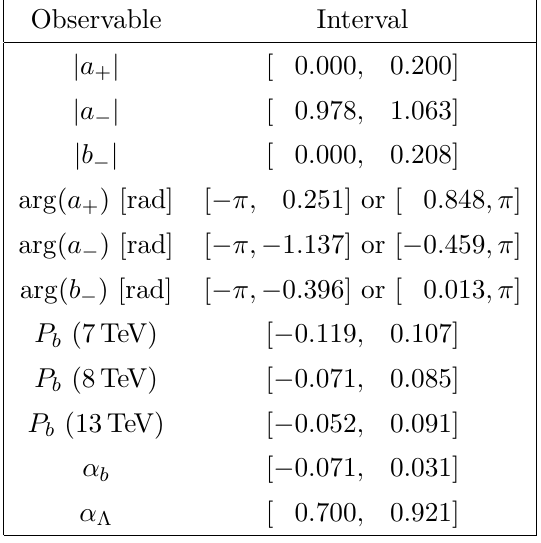
Table 6 . Intervals at 95% credibility level on the amplitudes, the polarisation and (cid:11) b from the Bayesian analysis. The interval on (cid:11) (cid:3) , with the external constraint removed, is also